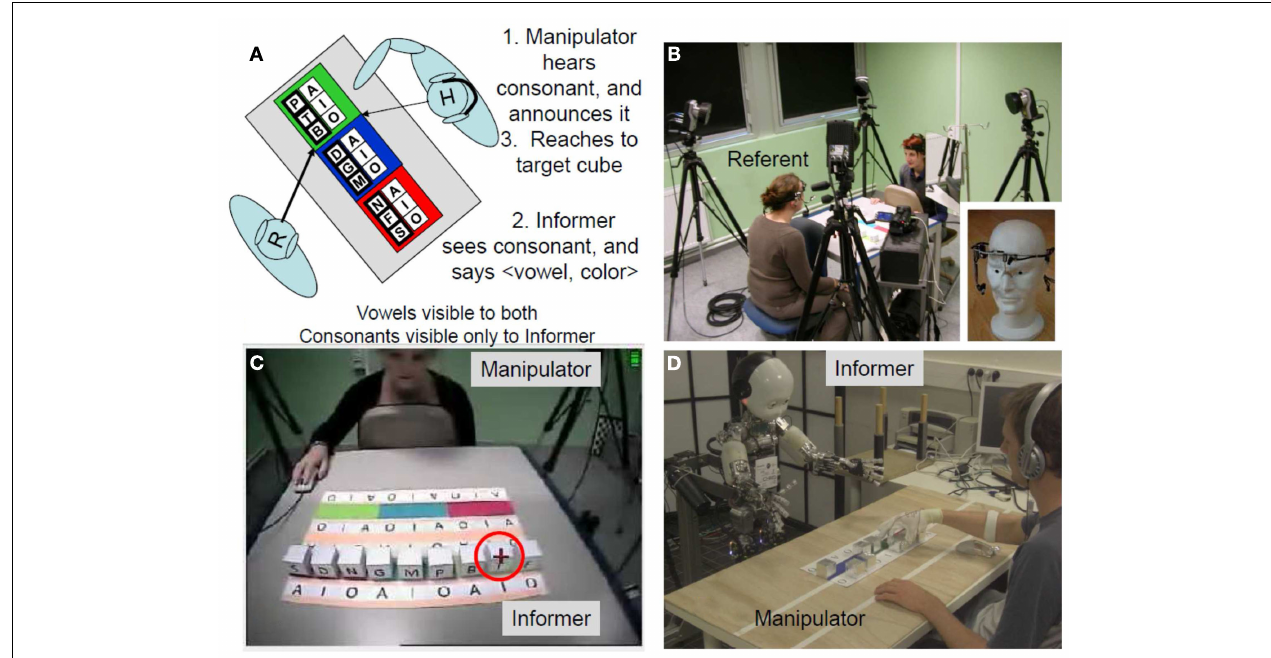
it, and announces the vowel-color location to the manipulator who grasps the cube and puts in front of himself. (B) Human–human setup. Eye movements of the referent subject are recorded by eye tracker (see inset). (C) View from the informer, taken from the eye tracker. Circled red cross indicates current eye position. (D) Human–robot setup.The iCub plays the role of the